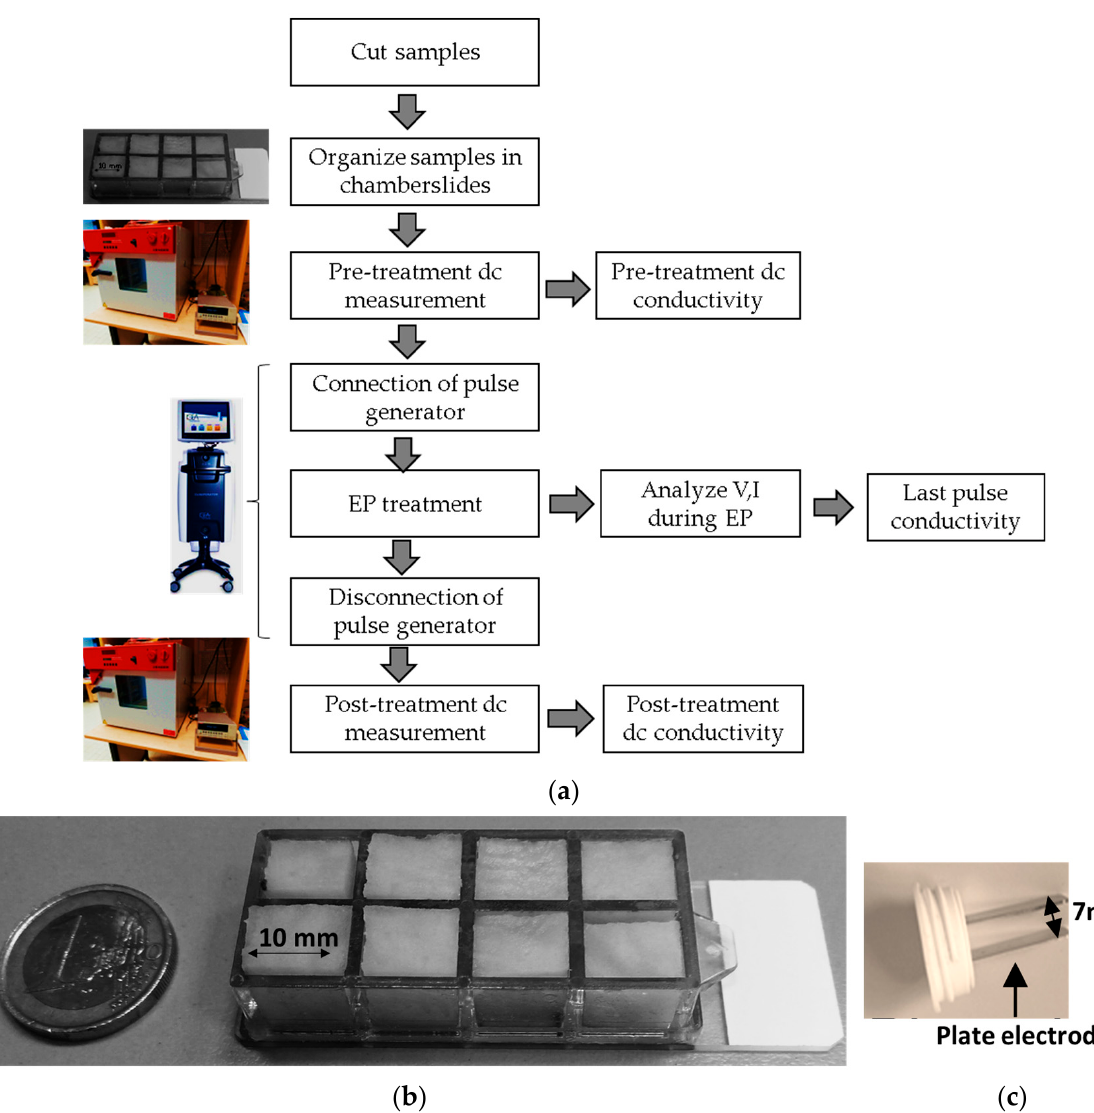
Figure 1. Flowchart of the proposed method ( a ), experimental set-up used for the evaluation of the electrical conductivity of the potato tissue ( b ), and the plate electrode used for the NSC characterization ( c ).